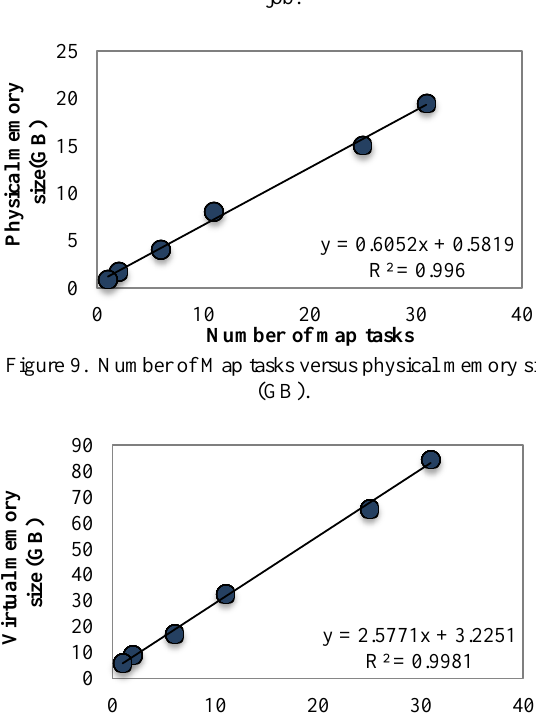
Figure 8. Number of map tasks versus elapsed real time of the job.